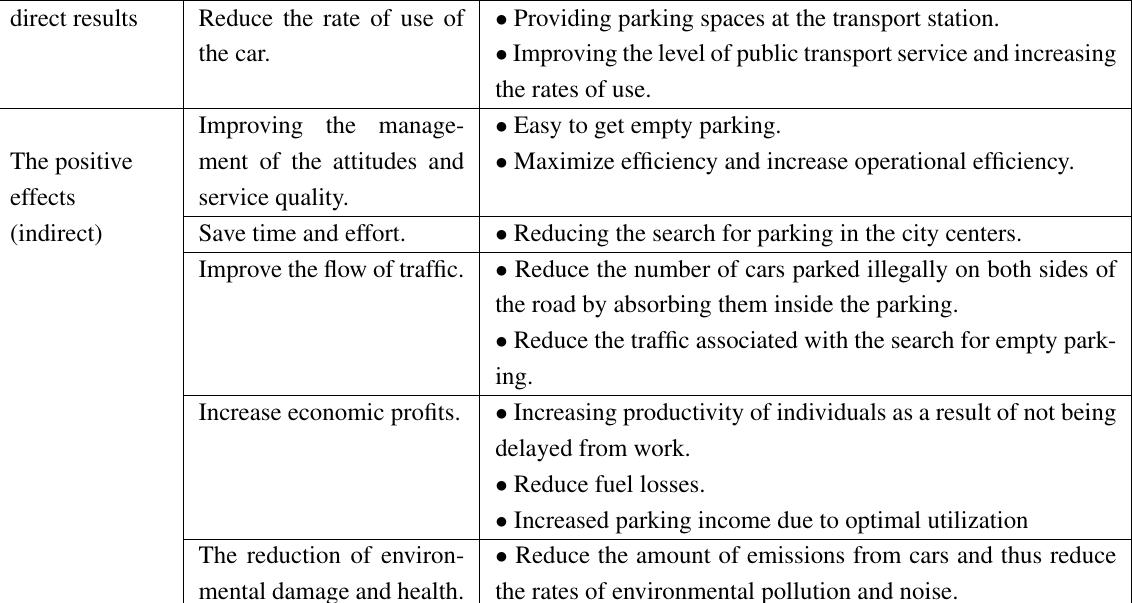
Table 2. Results of Park and Ride system and the positive effects. (Adeeb,